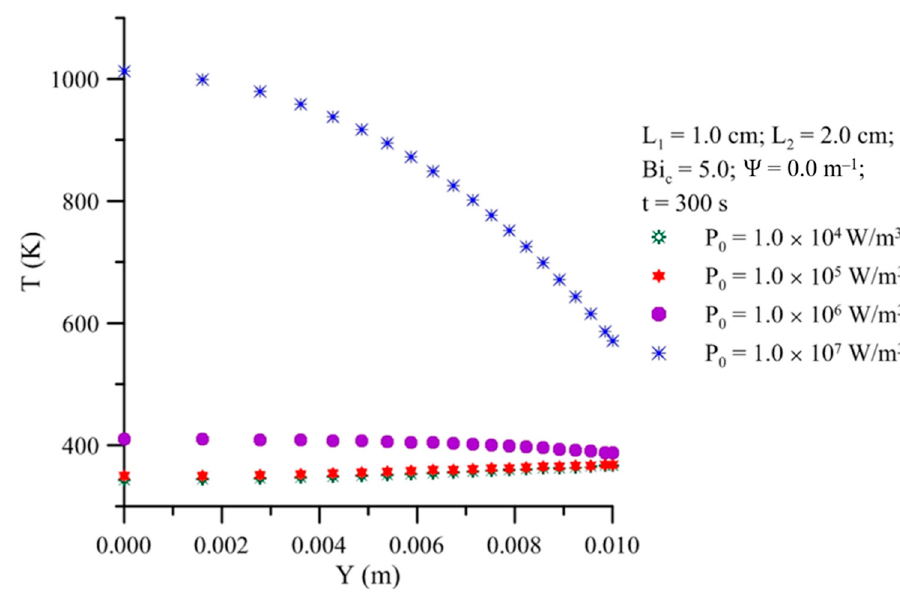
Figure 13. Temperature inside a prolate spheroidal solid with aspect ratio L 2 / L 1 = 2.0, di ff erent microwave power densities and fixed heat transfer Biot number ( y -axis, z = 0, t = 300 s).